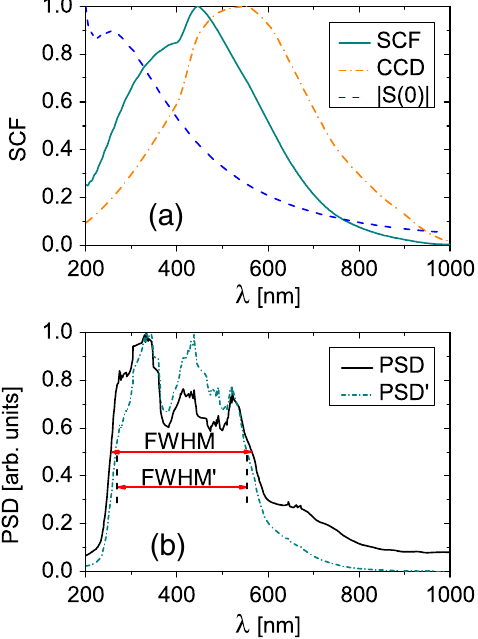
FIG. 8. (a) Spectral calibration function SCF (solid cyan curve) taking into account the dependence of the forward scattering amplitude j S ð 0 Þj on wavelength (dashed blue curve) and the quantum efficiency of the CCD sensor (dash-dot orange curve). The measured transmissivity of the liquid in the cuvette and of the cell walls is almost constant over the wavelength range indicated FIG. 7. (a) Simulated radial profiles of power spectra for and it is not displayed. (b) Comparison between the incoming different sample-detector distances. Here q ¼ j ⃗ q j . (b) Master power spectral density of SR radiation measured with a spec- curve for temporal coherence obtained through the scaling trometer [32] (PSD, solid black curve) and the detected spectrum described in Eq. (13). In contrast to Fig. 5, Talbot oscillations (PSD ’ , dash-dot cyan curve) obtained by means of multiplication superimpose. The common envelope of the reduced power for the SCF. Its effects on the radiation bandwidth are negligible, spectra fits the theoretical squared modulus of the radiation since the two spectra have full width at half maximum FWHM ¼ CDC of the form exp ð − τ 2 =t 2 Þ . Parameters used in the simu- coh 310 nm and FWHM 0 ¼ 290 nm, 2 fs. lation are λ ¼ 440 nm and t coh ¼